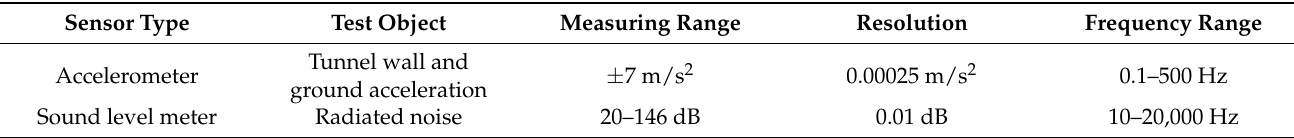
Table 1. Configurations of the applied